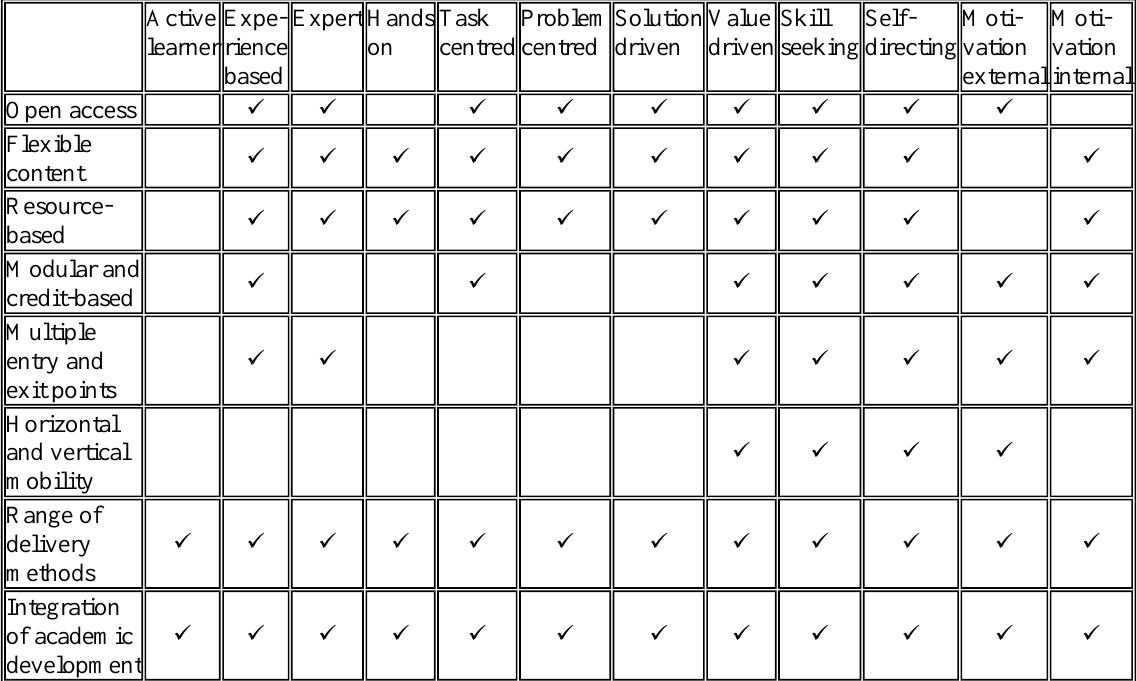
Table 2 Correlation between adult learning needs and national